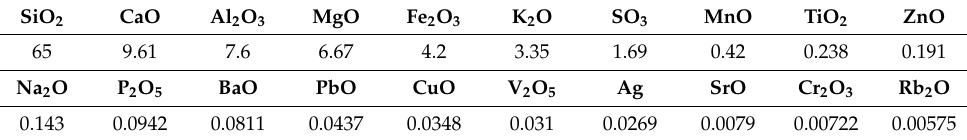
Table 1. Chemical component of ores